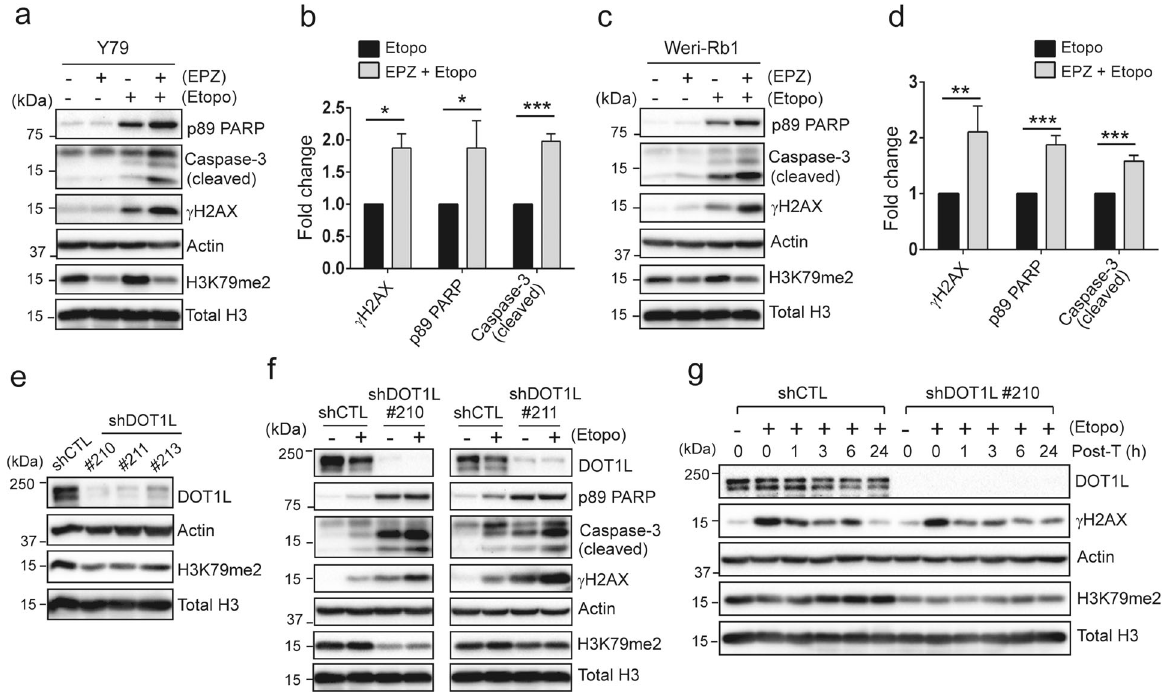
Fig. 2 Enhanced drug sensitivity upon DOT1L inhibition involves augmented apoptosis. a , c Immunoblots for indicated proteins in Y79 cells subjected to single or combined treatment of 20 µM EPZ5676 and 0.5 µM etoposide for 48 h ( a ) and in Weri-Rb1 cells treated for 20 h ( c ). b , d Densitometric analyses of the indicated proteins in a and c , respectively. The graph is shown as the mean ± SD of fold changes of the cotreatment group, relative to the normalized level in etoposide-treated cells ( N = 3). * P < 0.05; ** P < 0.01; *** P < 0.001. e Lentiviral knockdown of DOT1L in Y79 cells. f Immunoblots in Y79 shDOT1L cells treated with 0.5 µM etoposide for 48 h. g Immunoblots showing the recovery kinetics from acute DNA damage. Y79 control and shDOT1L cells were treated with 10 μ M etoposide for 1 h, and then placed in fresh media without the drug for the indicated time post-treatment (post-T) to allow the